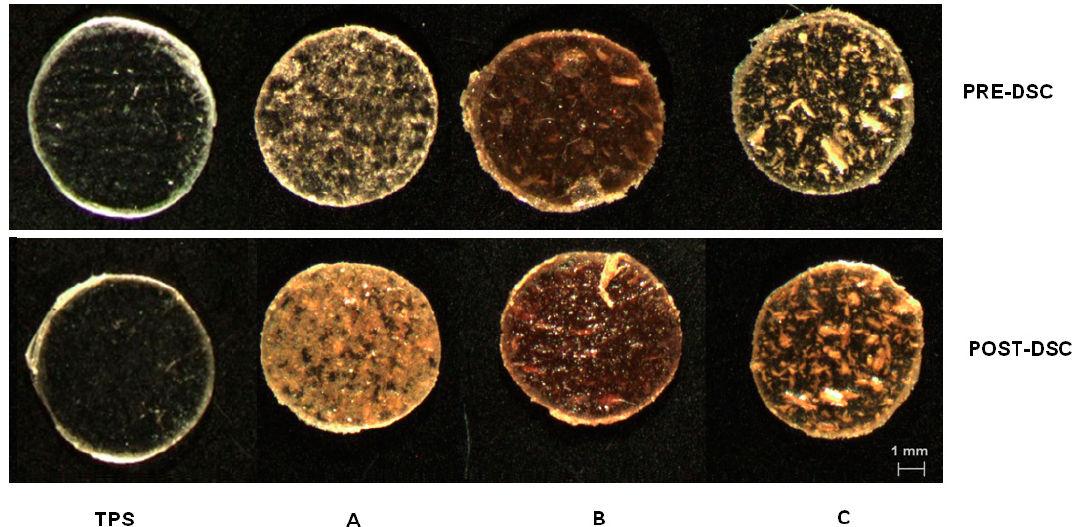
Figure 4. Samples of TPS and TPS–dry-nopal composites (type A, B and C, respectively) pre- and post-differential scanning calorimetry (DSC) analysis .